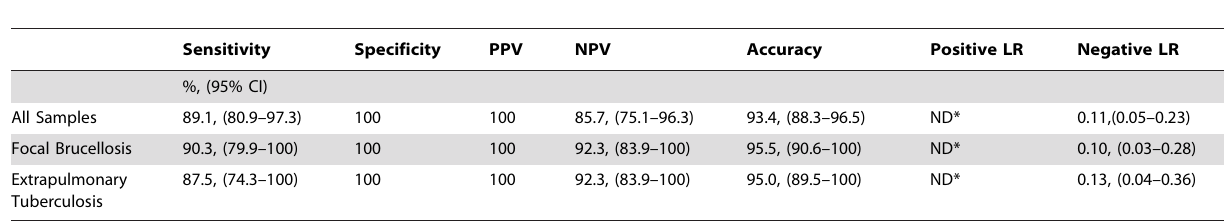
Table 3. Diagnostic yield of M RT-PCR in clinical specimens from patients with focal complications of brucellosis or extrapulmonary tuberculosis.